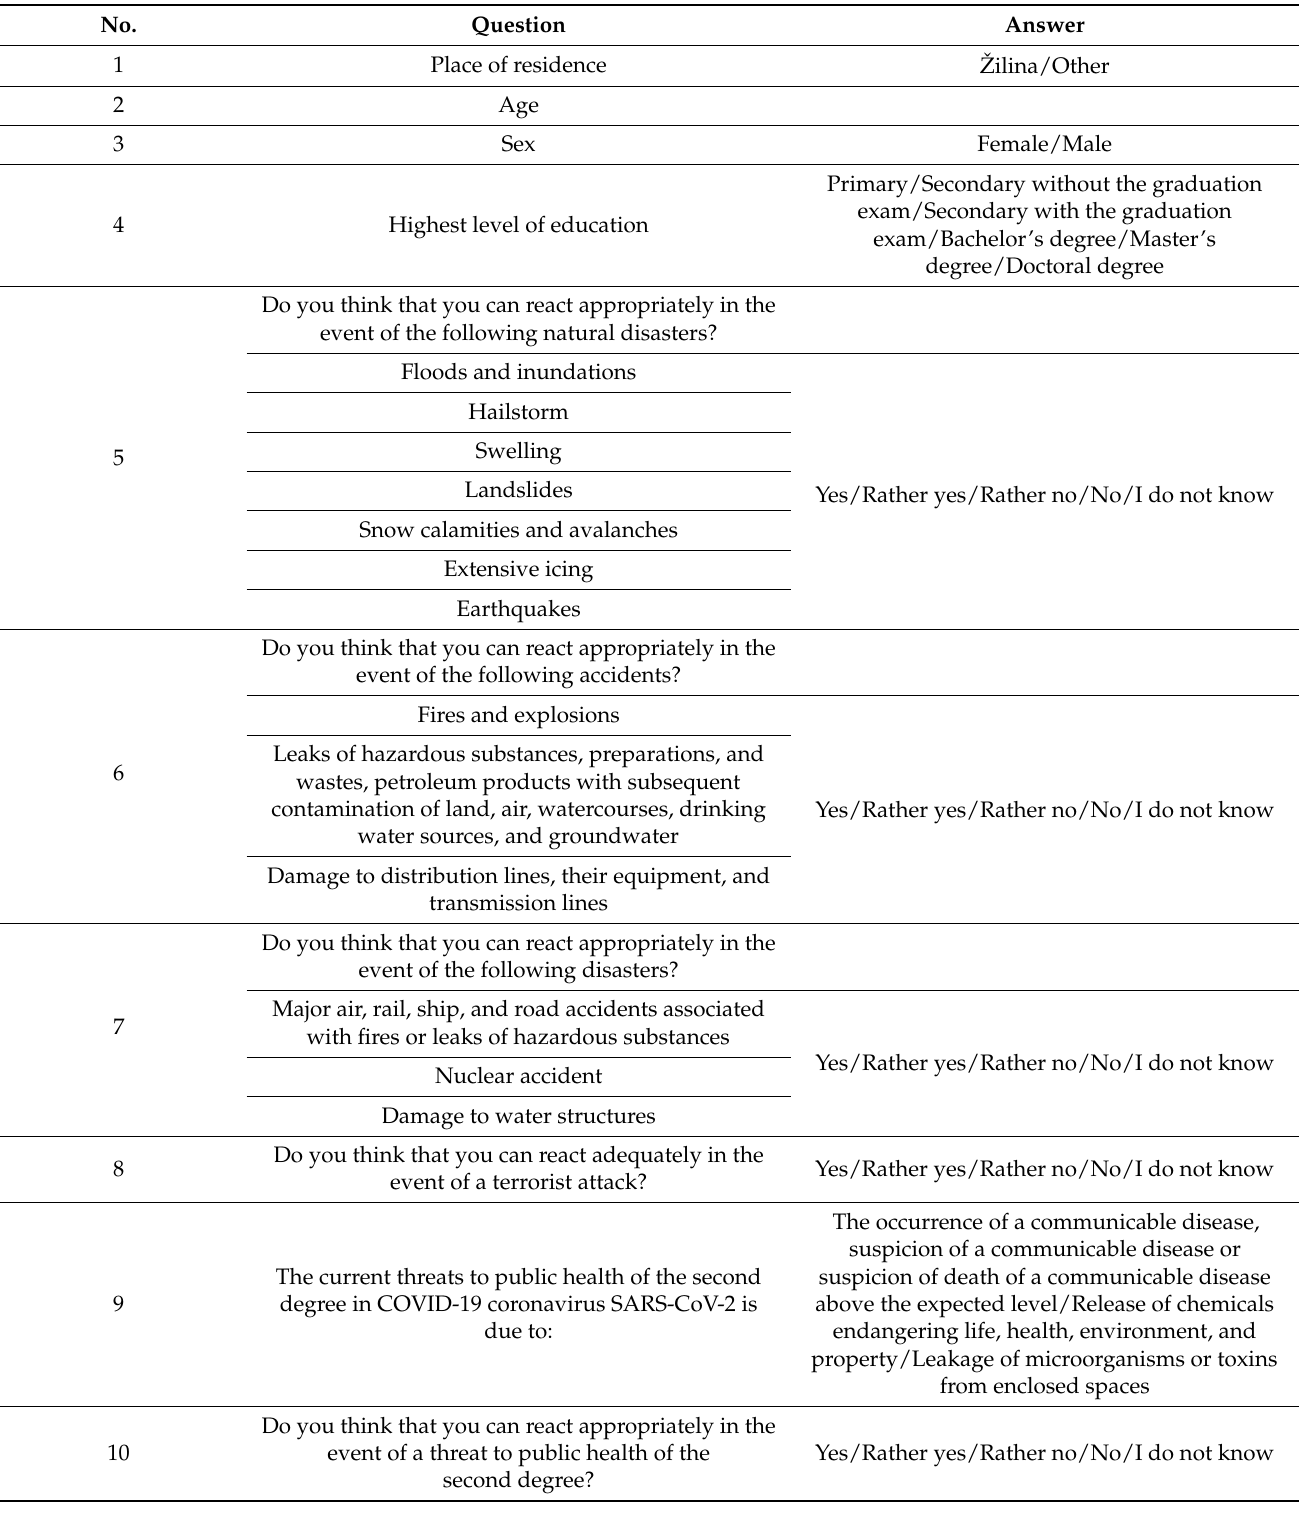
Table 1. Questions from the